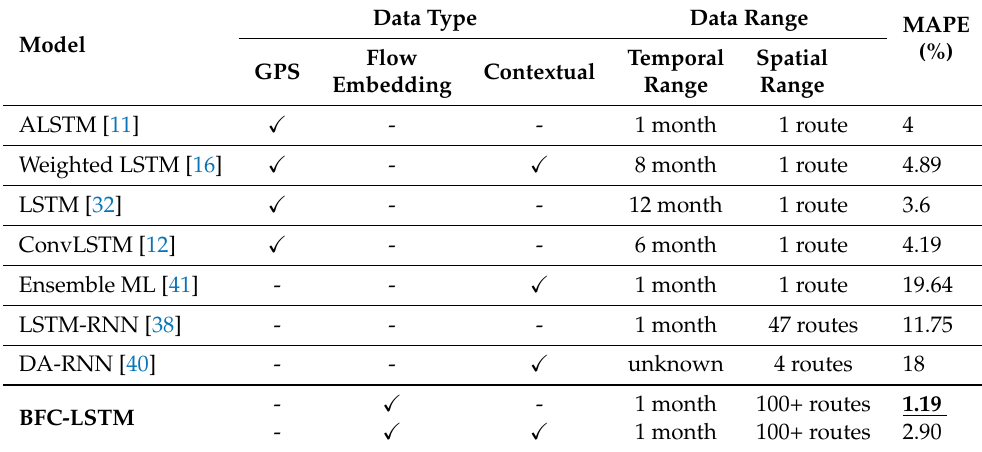
Table 1. Comparison of our approach based on BFC against previous prediction